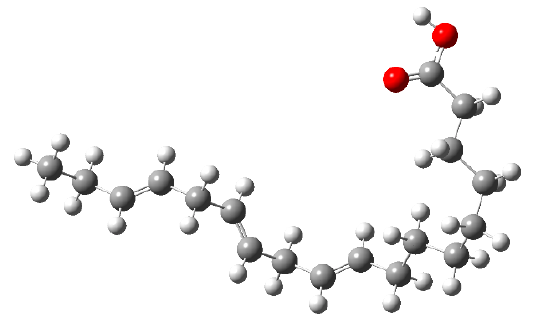
Figure 8. Optimized structure of the α -linoleic acid in the aqueous phase. Table 4. Calculated quantum chemical parameters for the neutral α -linolenic acid molecule. Chemical